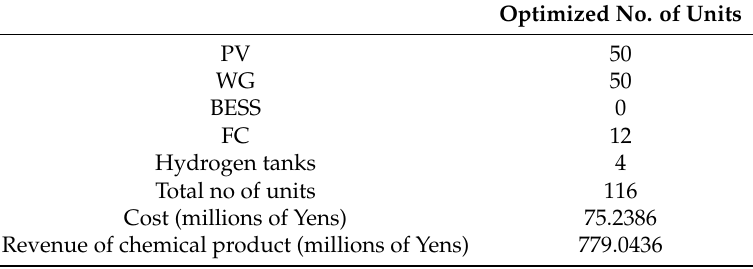
Figure 9. Scenario 4 results. Table 6. Scenario 4